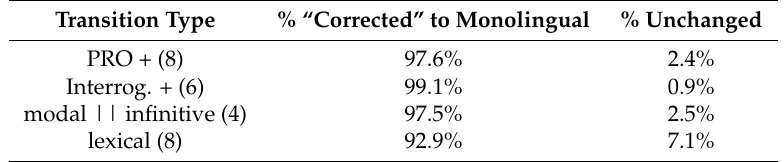
Table 4. Results of translation task: mixed Spanish~Portuguese stimulus utterances.